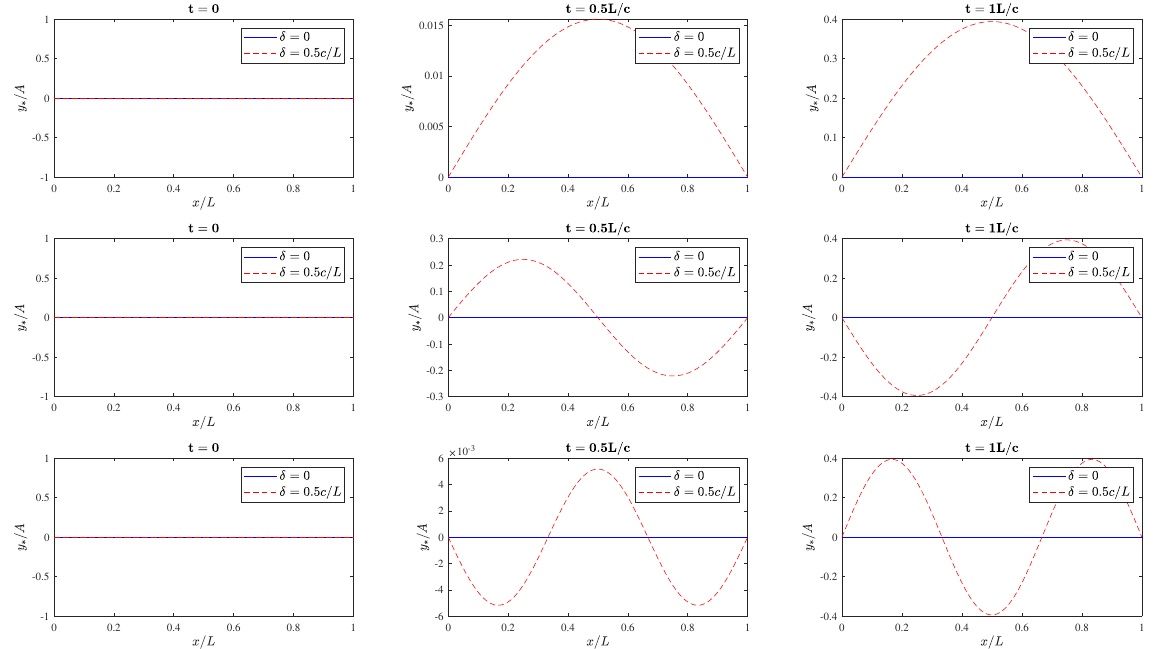
Figure 4. Total free plus forced resonant oscillations with opposing amplitudes at three distinct times. The blue solid lines correspond to no damping, δ = 0, whereas the red dashed lines correspond to oscillations with damping, δ = 0.5 c / L . In all the cases, the wavenumber is related to n by k = n π / L . Each row corresponds to a distinct set of values of the mode of free oscillation n and consequently on the value of wavenumber k n : the upper row is for { n , k n } = { 1, π / L } , the middle row is for { n , k n } = { 2,2 π / L } and the bottom row is for { n , k n } = { 3,3 π / L } . The forced frequency is given by ω = kc . The plots are obtained for α = 0 and β = π /2 − α